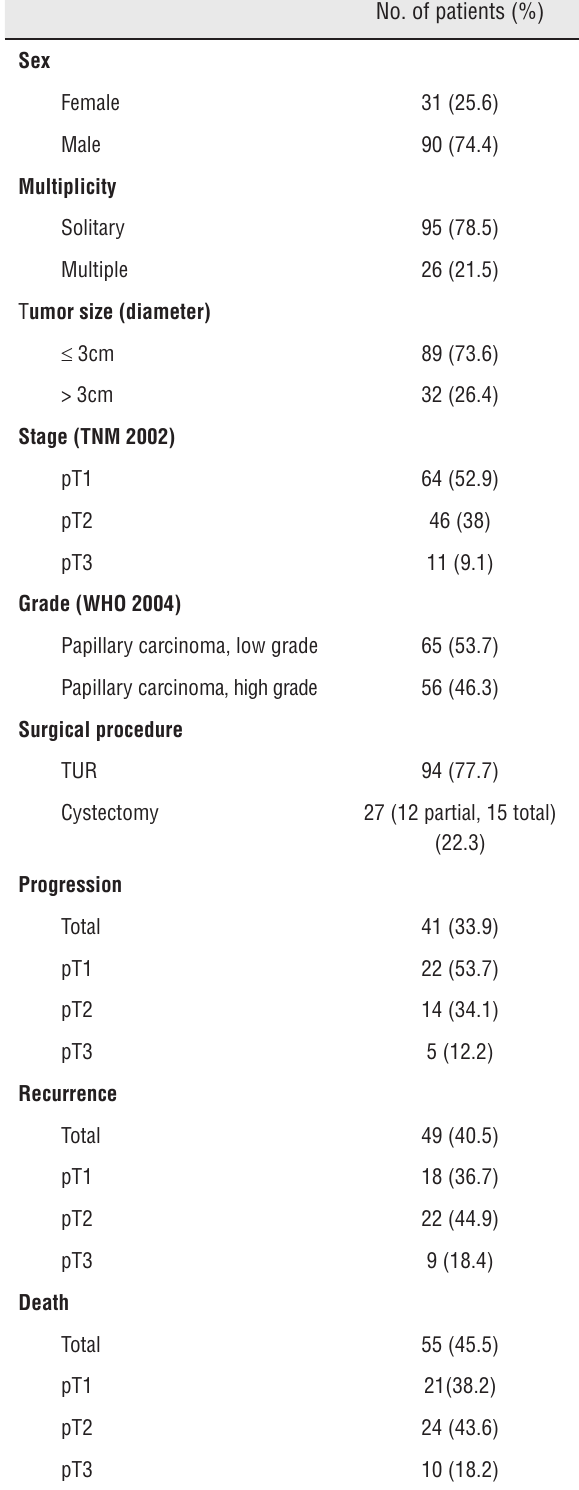
Table 1 - Clinical and pathological data of the bladder